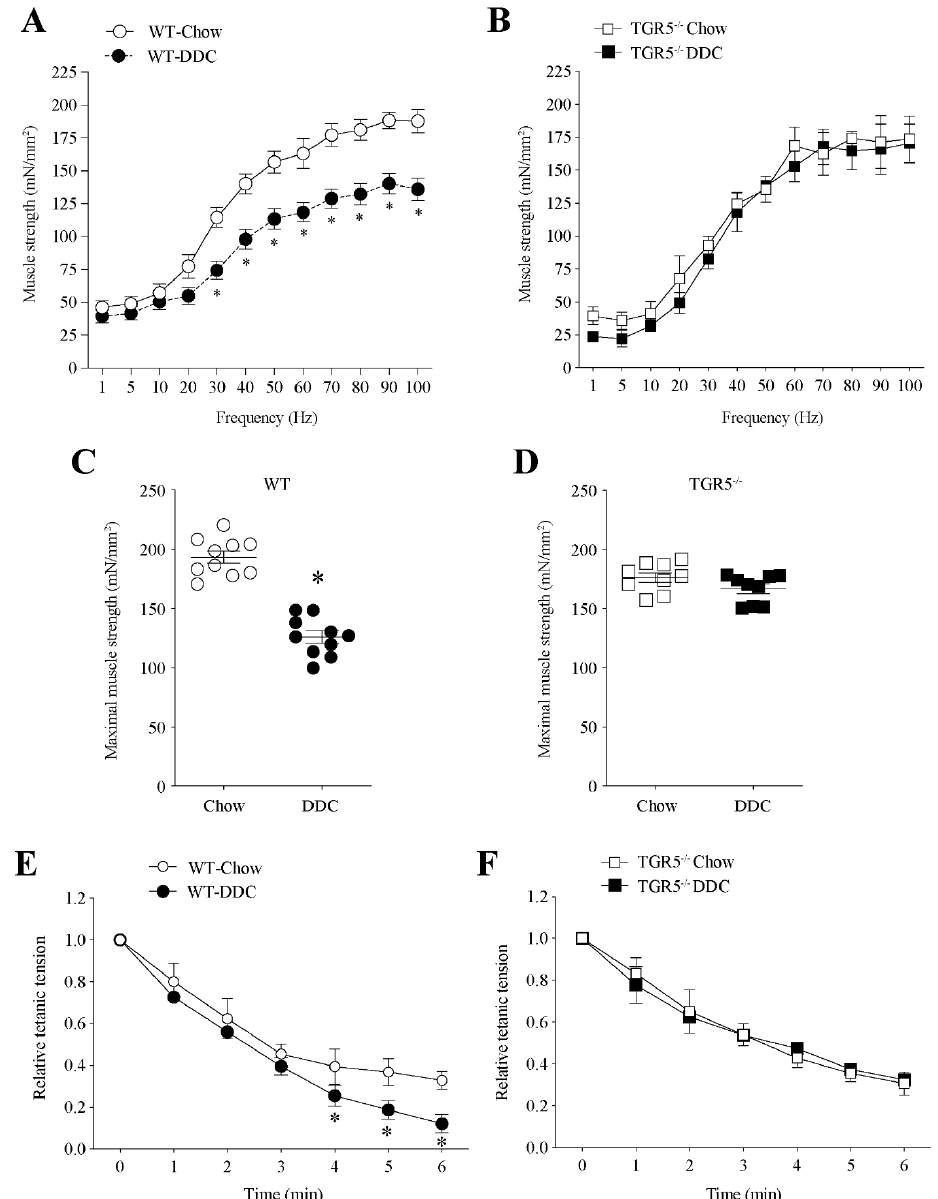
Figure 3. The decreased tetanic force in mice with DDC-induced CLD is dependent on TGR5 expression. C57BL/6J male WT and TGR5 -/- mice were fed with a chow or DDC-supplemented diet for 6 weeks. When the experiment was completed, the tibial anterior (TA) muscle was dissected, and a curve of force versus frequency was determined for WT ( A ) and TGR5 -/- ( B ) mice. The values correspond to the mean ± SEM ( n = 7–9, * p < 0.05, two-way ANOVA, Sidak’s multiple comparison test). The maximal tetanic force for WT ( C ) and TGR5 -/- ( D ) mice was plotted. The values correspond to the mean ± SEM ( n = 7–9, * p < 0.05 vs. chow, t-test). Fatigue determination was evaluated in the TA of WT ( E ) and TGR5 -/- ( F ) mice. The values correspond to the mean ± SEM ( n = 7–9, * p < 0.05, two-way ANOVA, Sidak’s multiple comparison test).